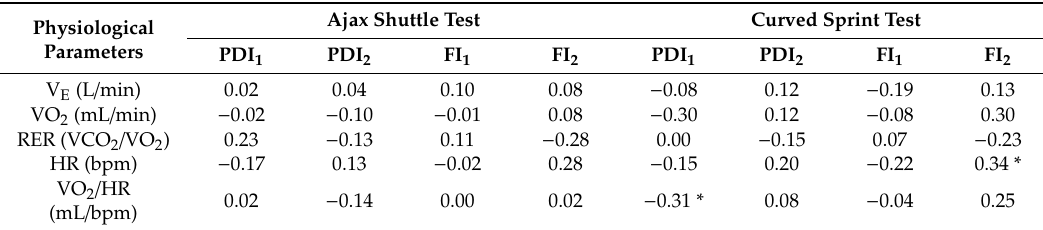
Table 8. Relationship between PD and FI in AST and CST and physiological parameters at the predicted VO 2max level during the Yo-Yo